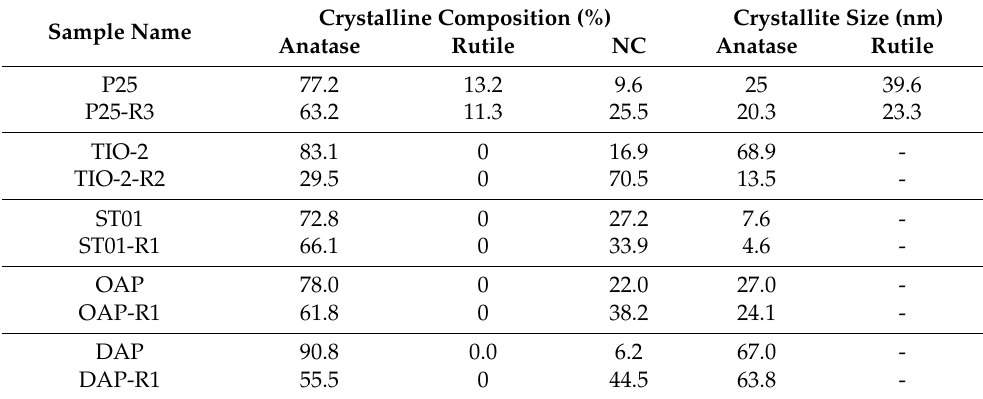
Figure 7. XRD patterns for TIO-2-based samples: pristine and modified (TIO-2-R1) titania mixed with internal standard (NiO): original data were normalized to the standard. Table 3. Crystalline properties, estimated with an internal standard